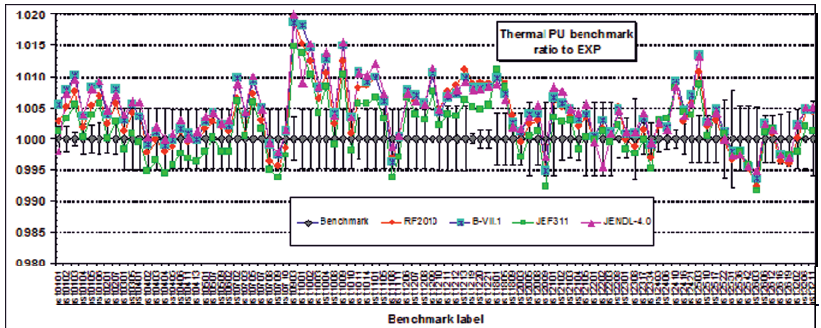
Fig. 5: Thermal Pu benchmarks.